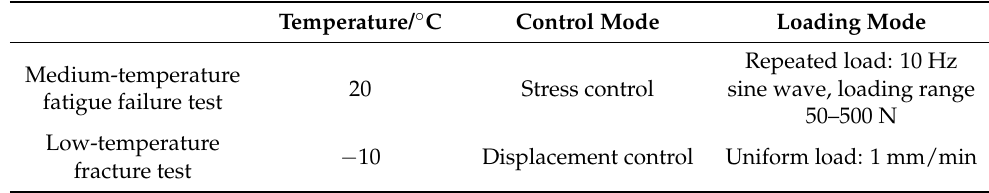
Table 10. Loading conditions of SCB.